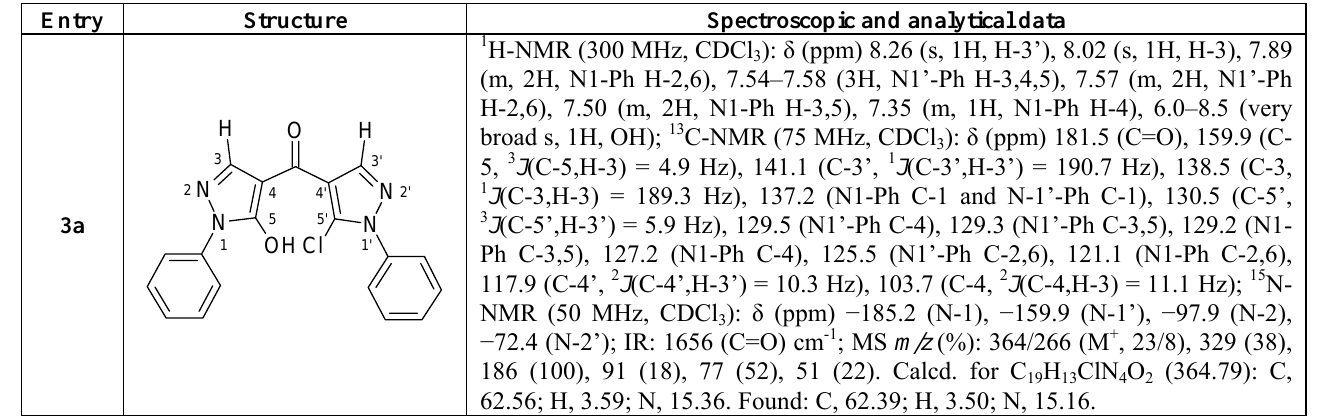
Table 1. Spectroscopic and analytical data of compounds 3a - g and 8a - b